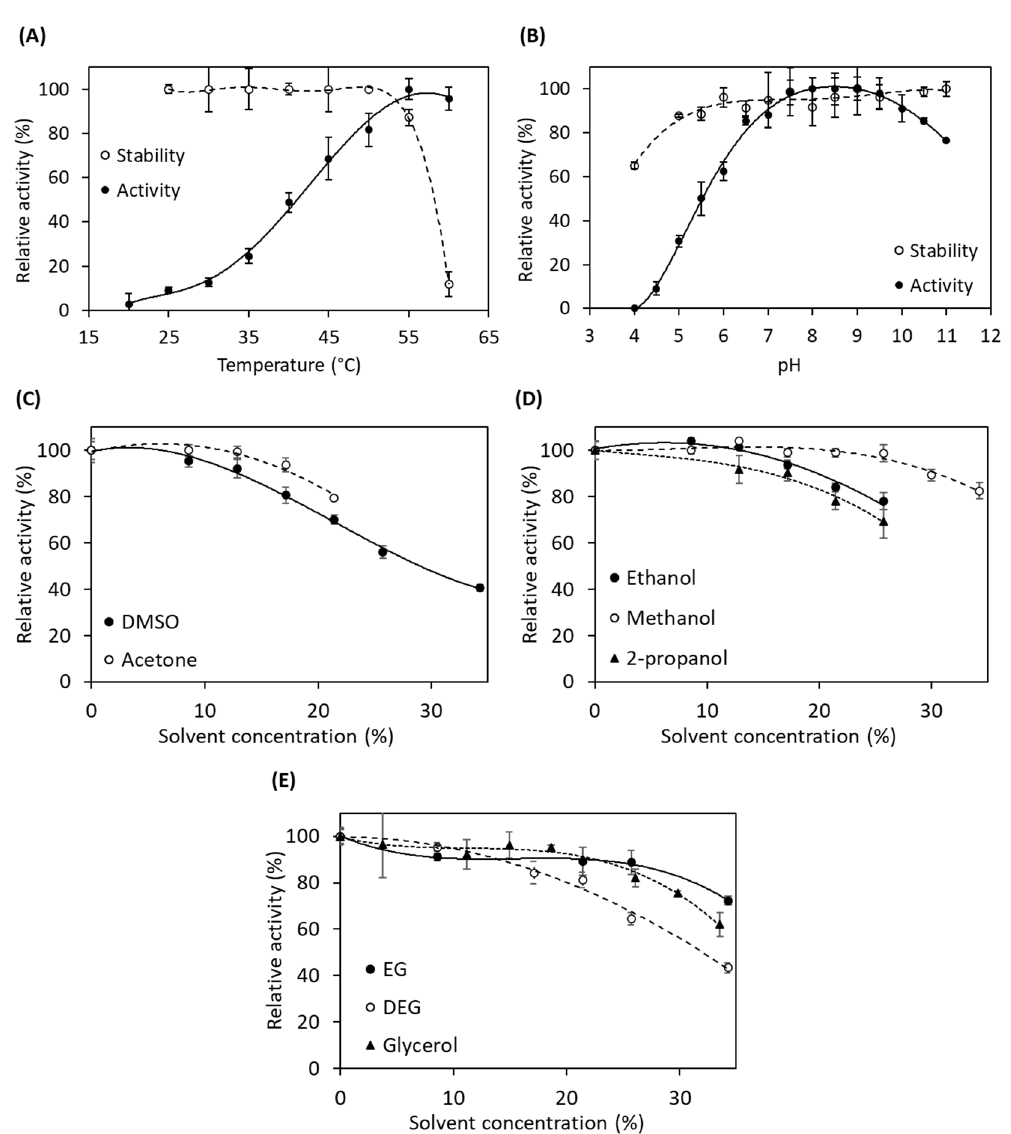
Figure 4. Biochemical characterization of Au AHLA. Effect of temperature ( A ) and pH ( B ) on Au AHLA activity and stability. Effect of organic co-solvents on Au AHLA activity: aprotic polar solvents ( C ), alcohols ( D ), and glycerol and glycols ( E ).